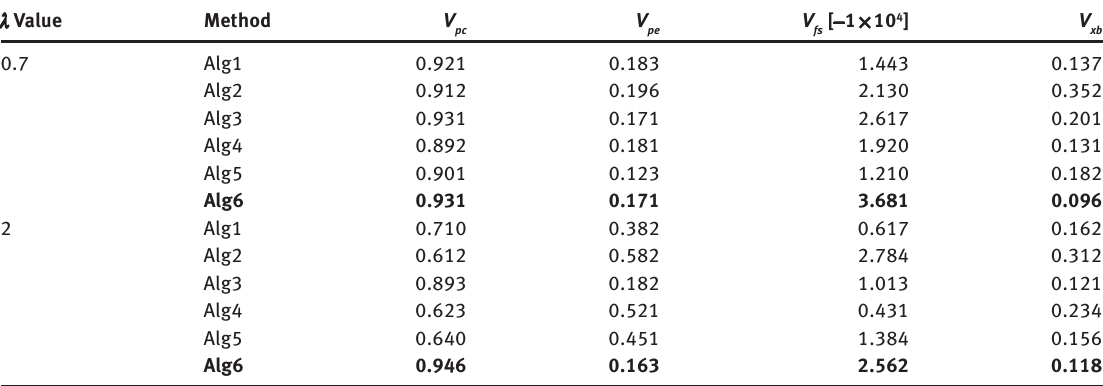
Table 3: Values of Validity Indices for Car